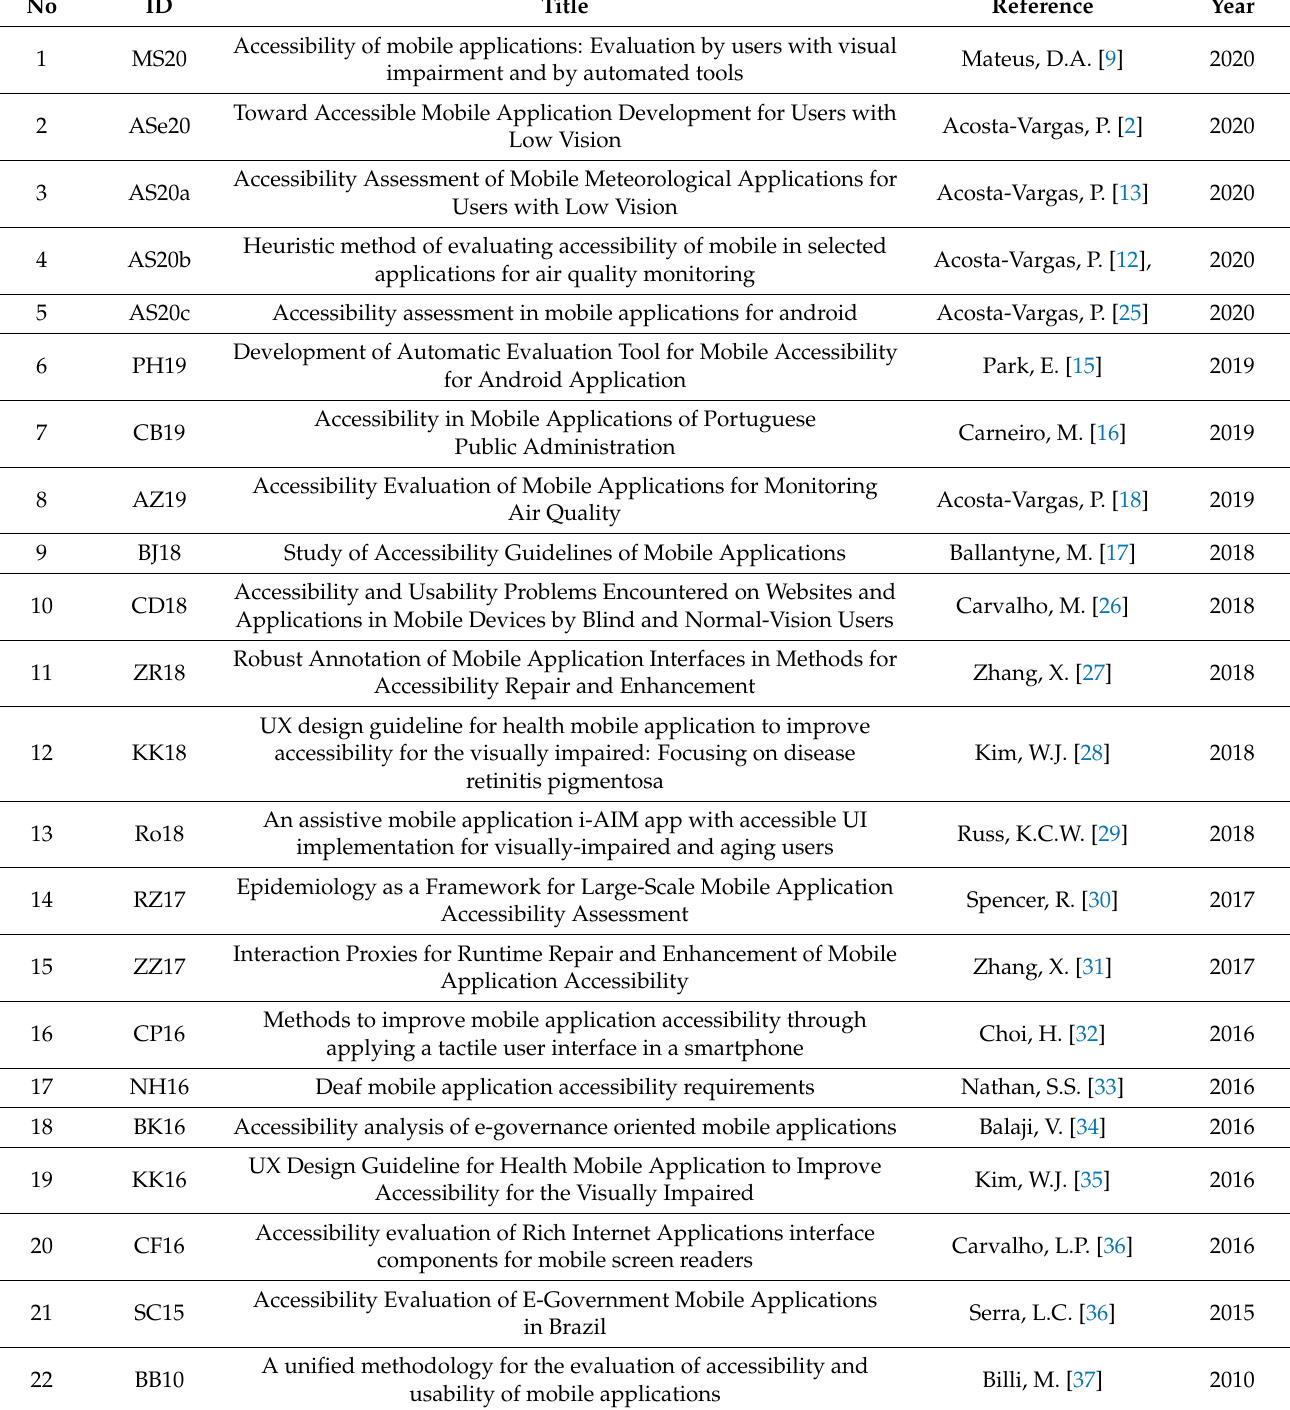
Table 4. List of scientific articles selected in this